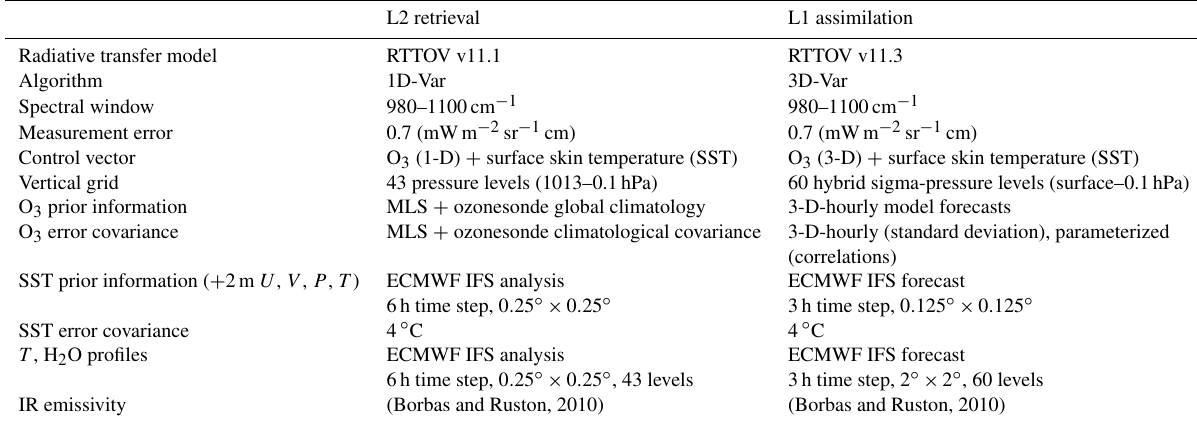
Table 2. Summary of the configuration of SOFRID L2 retrievals and MOCAGE L1